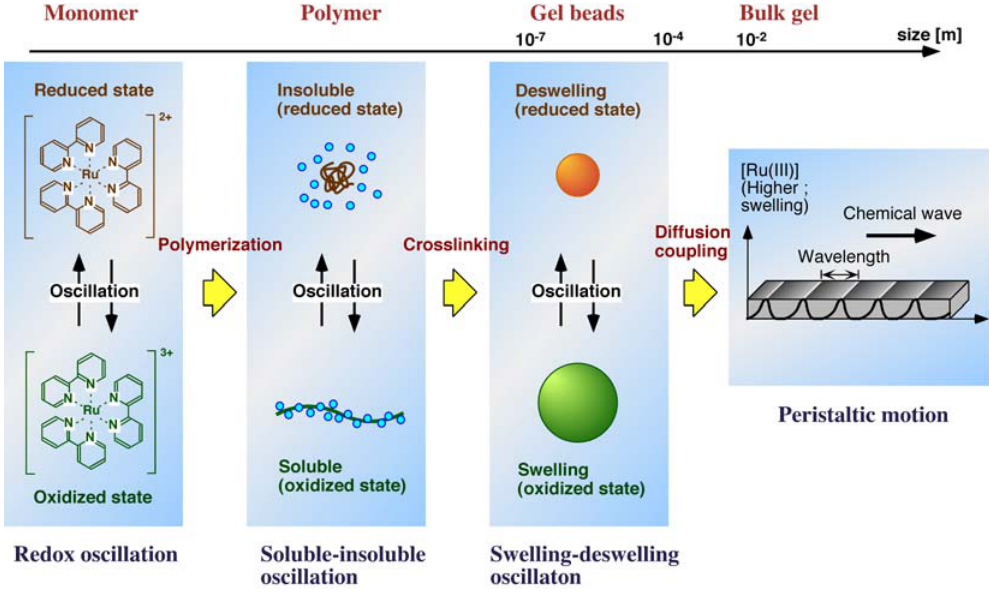
Figure 8. Synchronization in self-oscillating gel over the range from microscopic to macroscopic